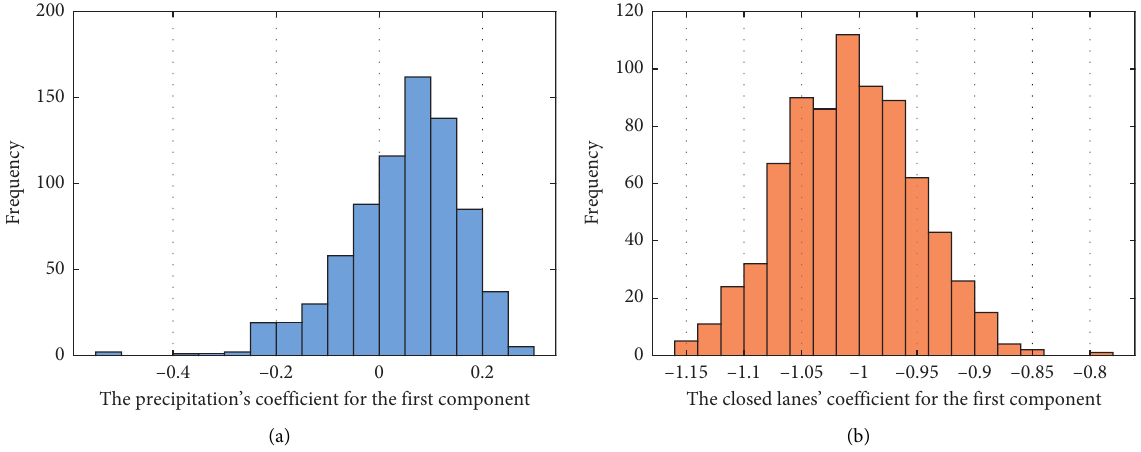
Figure 7: Histogram of the precipitation (a) and closed lanes ratio (b) coefficient for the first component (congested